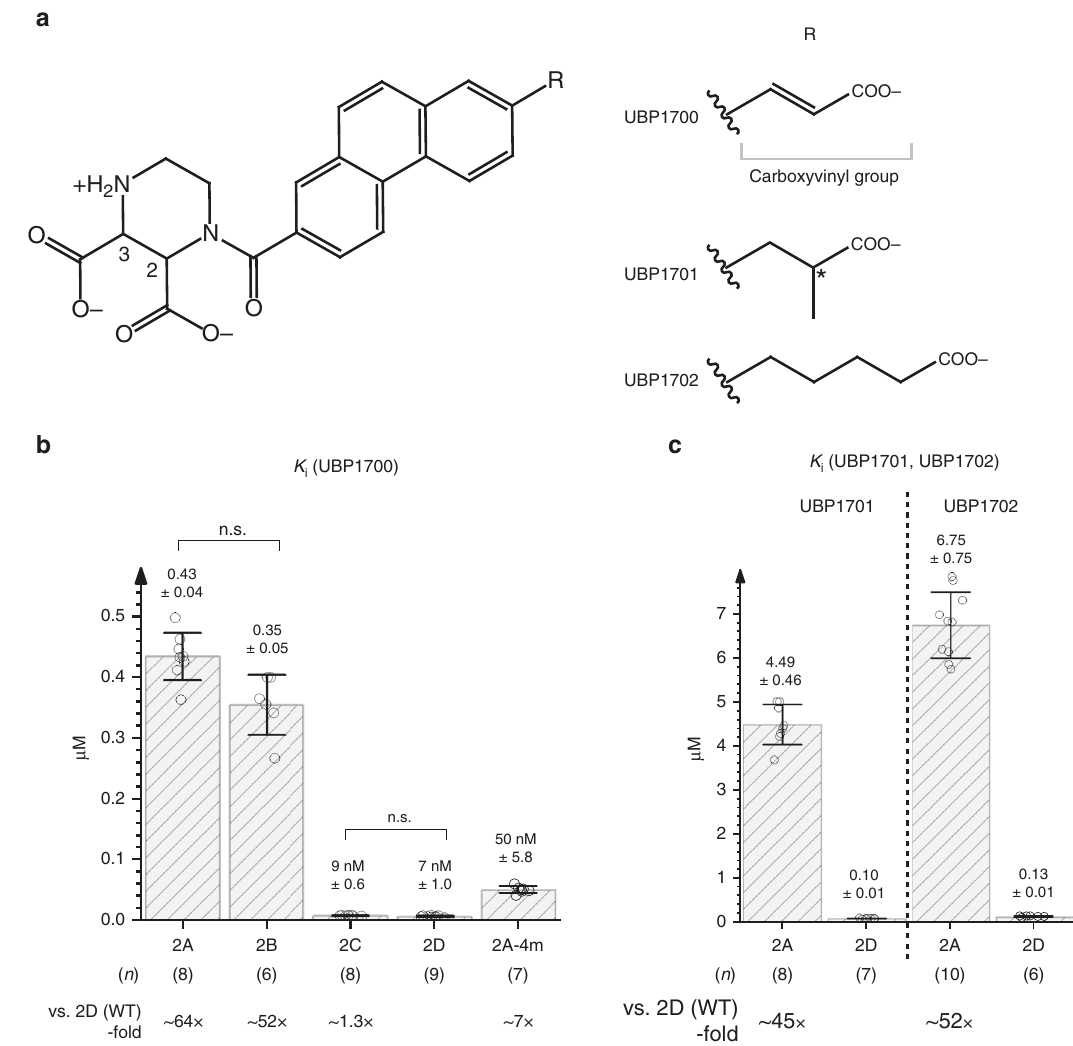
Fig. 7 Designed compounds with increased GluN2C/2D selectivity and potency. a UBP1700, 1701, and 1702 have carboxylate moieties of different length, bulkiness, and rigidity. The chiral center in the R-group of UBP1701 is marked with an asterisk. At physiological pH the amine group of the piperazine ring is protonated and therefore positively charged and the three carboxylic acid groups are negatively charged. b K i values for UBP1700 inhibition were measured on GluN1-4a/GluN2 ( a – d ) NMDARs and GluN1-4a/GluN2A-4m NMDAR as described in Fig. 2. Inhibition dose-response was observed in the presence of 100 μ M glycine, 1 or 3 μ M L -glutamate, and varying concentrations of UBP1700 (Supplementary Fig. 4). Pairwise comparison shows subtypes have different potencies ( p < 0.05 with two-tail t -test and Bonferroni correction) except where stated (n.s.). c Potencies of UBP1701 and UBP1702